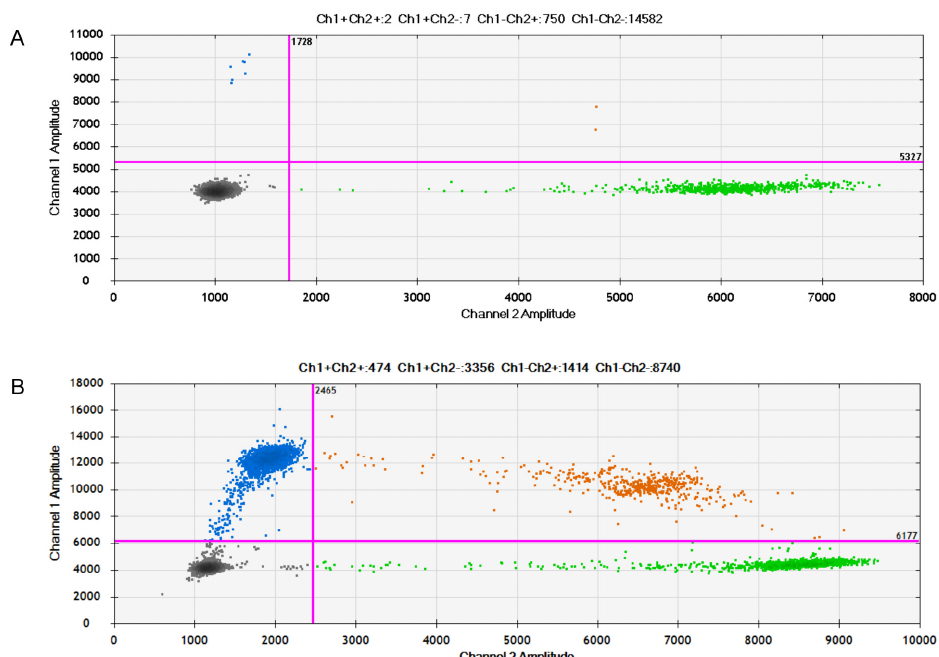
Figure 4. Two-dimensional scatter plot presenting four clusters obtained with mutant K-RAS and its wild-type allele. ( A ) Analysis of ctDNA extracted from patient’s plasma. ( B ) Analysis of ctDNA extracted from patient’s brain tumour mass. In both graphs ( A , B ), the fluorescence of channel 1 (FAM) is plotted against the fluorescence of channel 2 (HEX) for each drop (colour: blue, black, orange, or green). Drops are grouped into the following groups: FAM negative, negative HEX (doubly negative drops—black marking); FAM positive, HEX negative (positive drops for the sample with mutation—blue marking); FAM negative, HEX positive (positive drops for wild-type sample—green marking); FAM positive, HEX positive (doubly positive drops, containing both wild-type and mutated DNA—orange labelling). The ddPCR™ KRAS G12/G13 Screening Kit (Bio-Rad’s catalogue number 1863506) detects seven K-RAS mutations: G12A, G12C, G12D, G12R, G12S, G12V, G13D (blue labelling), without discriminating each one of them.